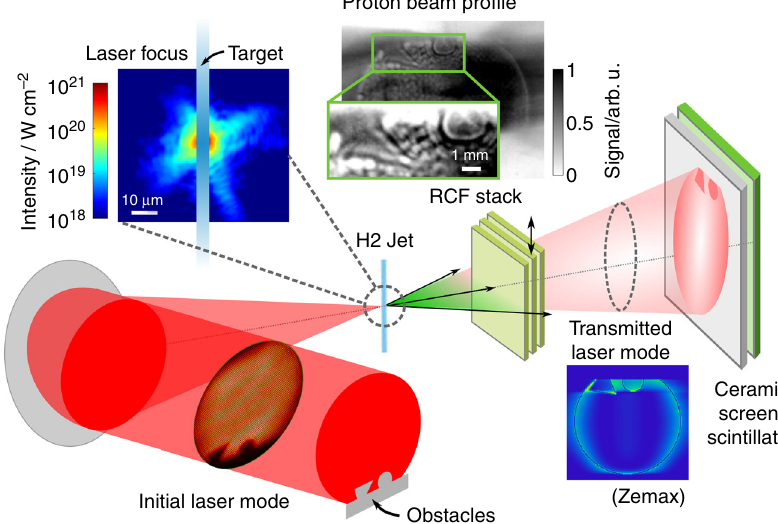
Fig. 1 Schematic of experimental setup and example measurement. Obstacles were inserted in the collimated Draco laser beam before focusing it onto a micrometer sized solid Hydrogen jet target with an f/2.5 off-axis parabolic mirror. An image of the laser focus (logarithmic color scale) is overlapped with a schematic image of the Hydrogen jet (5 μ m diameter) to visualize the amount of laser intensity present in the outer lobes of the focus. Proton beam pro fi le measurements via radiochromic fi lm (RCF) stacks inserted on-demand at 45 mm behind the target (7 MeV layer displayed, zoom-in on obstacles with different gray scale to emphasize imprinted structures) and a scintillator at 12.5 cm (exemplary data shown in Methods section) clearly reproduce the shape of the inserted obstacles, namely pick-off mirror and triangle. Zemax simulations con fi rm the effect of spatial fi ltering in the laser focus on the transmitted light intensity distribution that was measured by imaging a ceramic screen situated in front of the scintillator detector